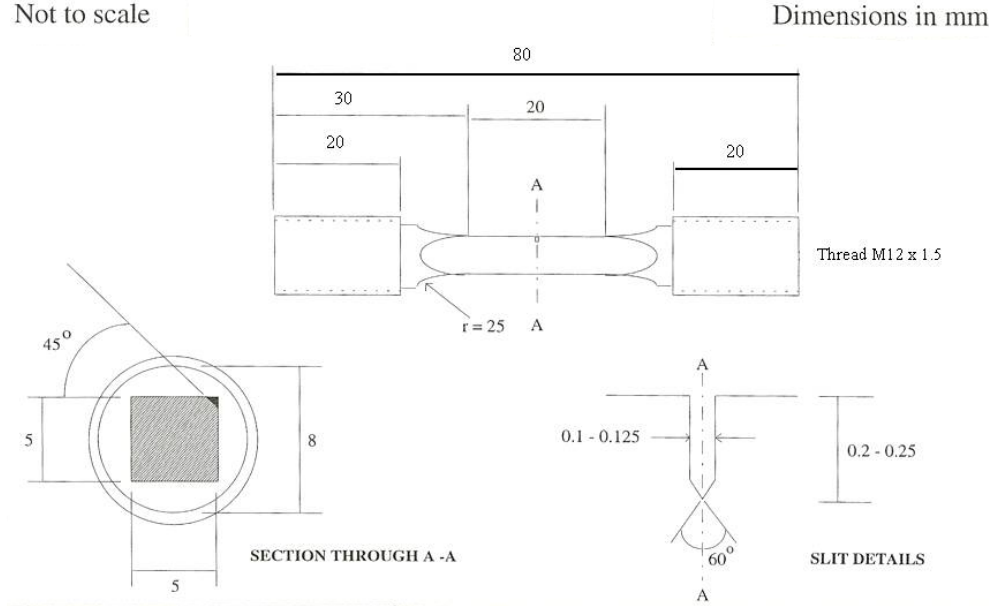
Figure 1. Corner crack specimen designed for thermo-mechanical fatigue (TMF) crack propagation in induction coil.